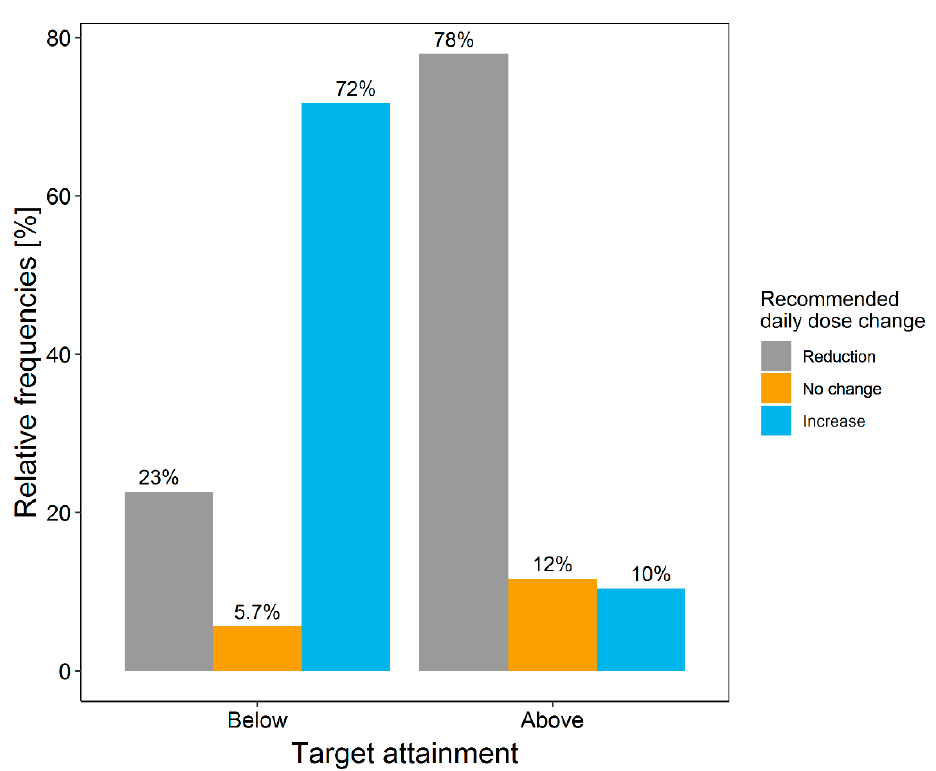
Figure 4. Frequency of daily meropenem dose adjustments by comparing the recommended daily dose to the actual administered daily dose at Charité-Universitaetsmedizin Berlin, stratified by non-attainment of the target range of the administered dosing regimen. Of 306 samples, 46 were below and 160 were above the target range.